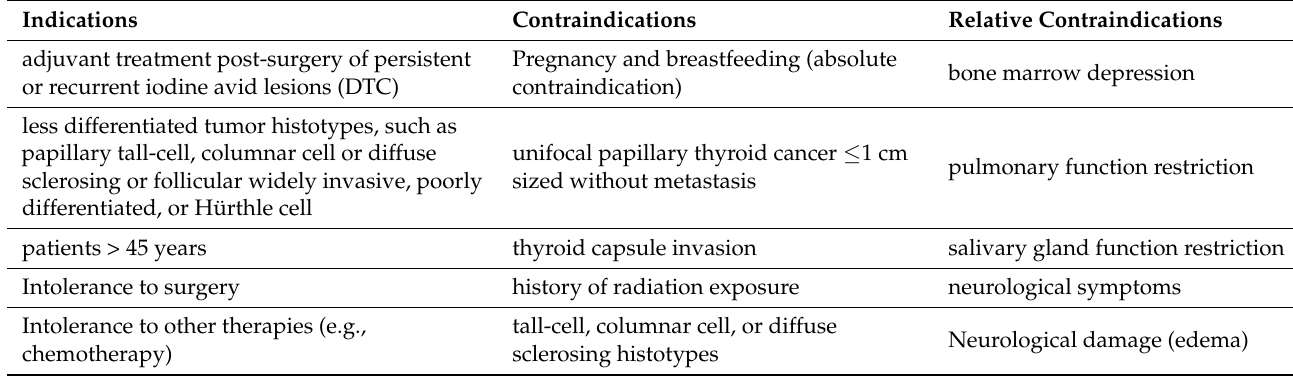
Table 3. EANM Indications, contraindications, and relative contraindications for RAIT.